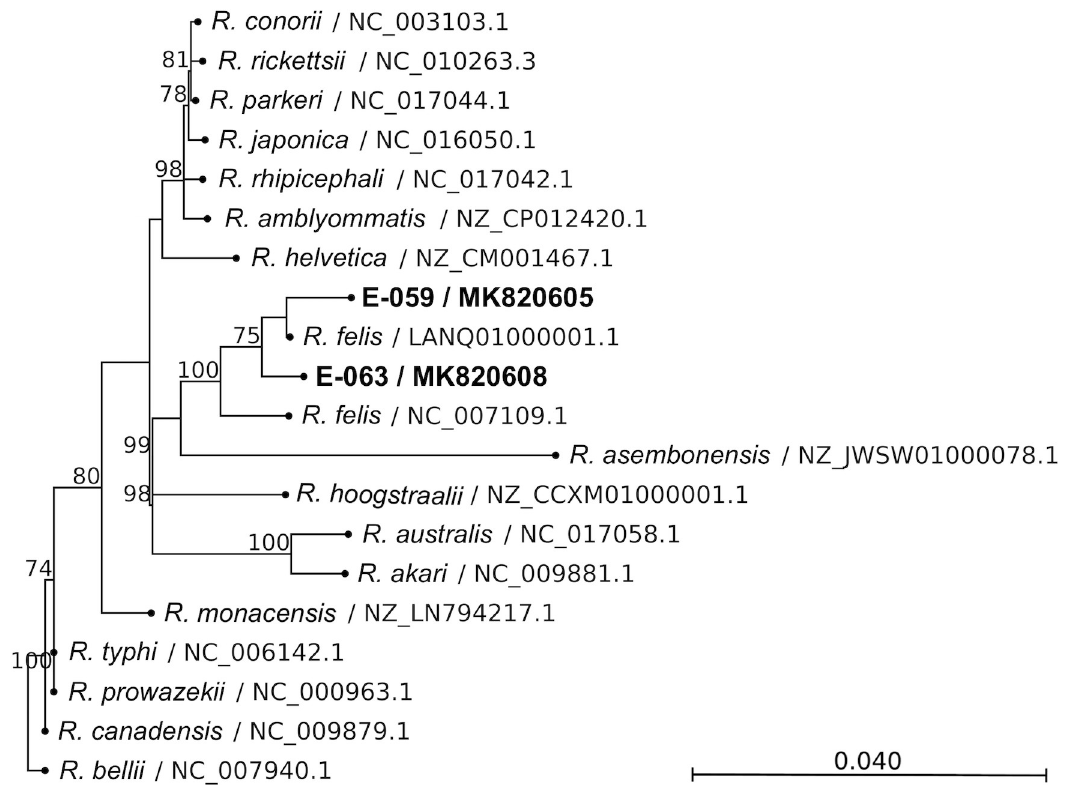
Fig 3. Phylogenetic tree comparing gltA gene fragment of Rickettsia from patients to other Rickettsia species. Gene fragment size was 1,060 bp. Bootstrap percentages ( � 60%) are shown on internal branches. Label indicates Rickettsia species / accession number. The scale bar represents the number of nucleotide substitution per site.